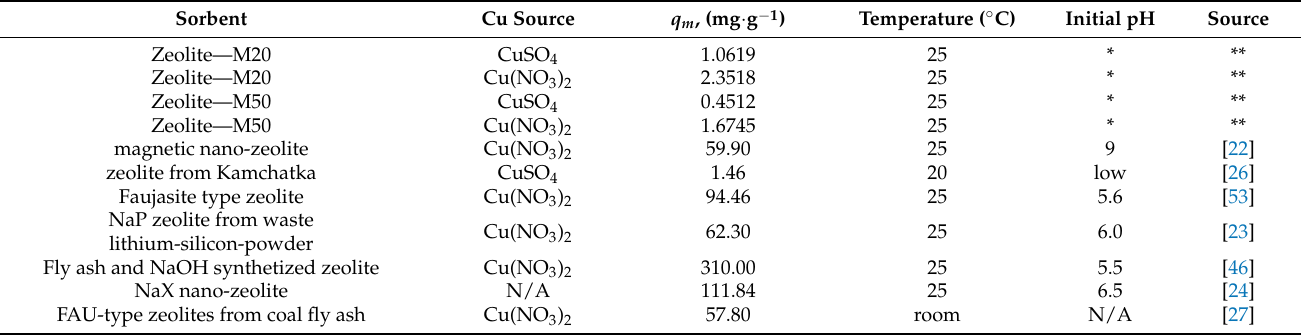
Table 10. A comparison of sorption capacities of different Cu